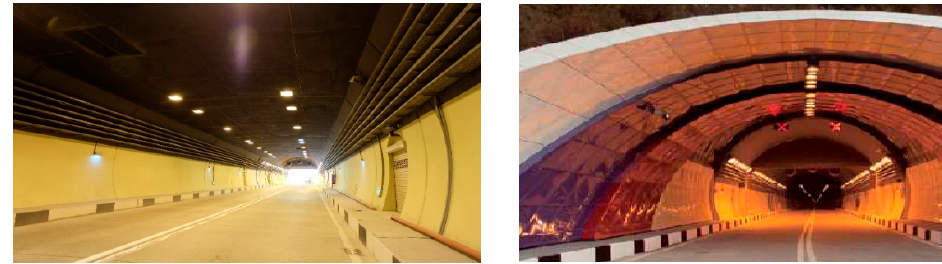
Figure 2. Roki road tunnel through the main Caucasian ridge (North Ossetia) with fireproofing ensured using Pyro-Safe Aestuver Т slabs, 2013–2014.